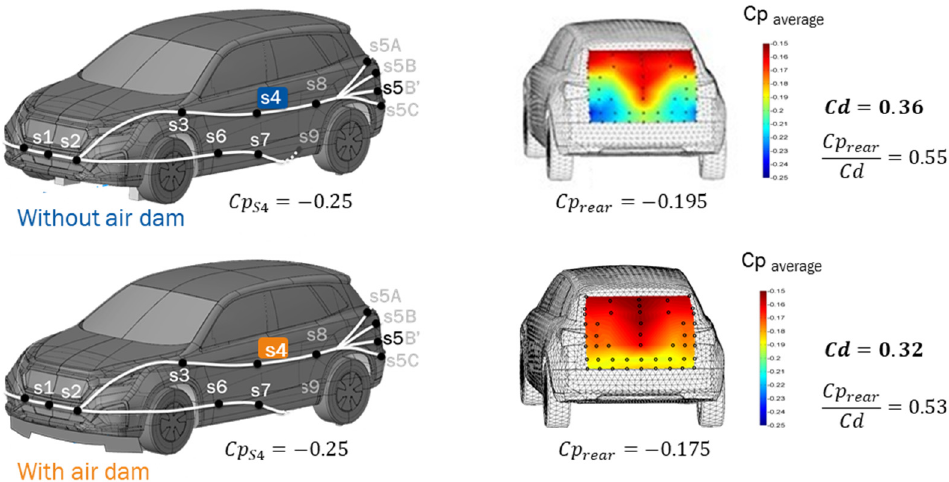
Figure 3. Rear pressure coefficient with and without air dam. 𝐶𝑝 (cid:3045)(cid:3032)(cid:3028)(cid:3045) 𝐶𝑑⁄ Ratio is around 50% in configurations in both configurations in experiments.